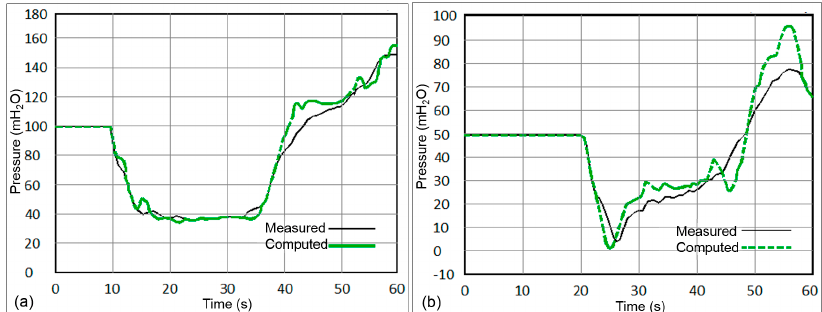
Figure 16. Measured and computed pressure traces ( a ) at discharge header of Pumping Plant 4 and ( b ) at the air valve located at station 73 + 476.